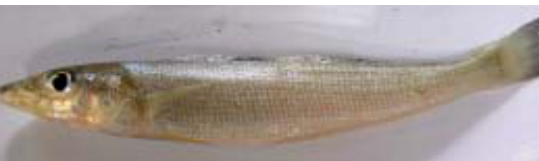
Image 27. Silver Sillago Sillago sihama